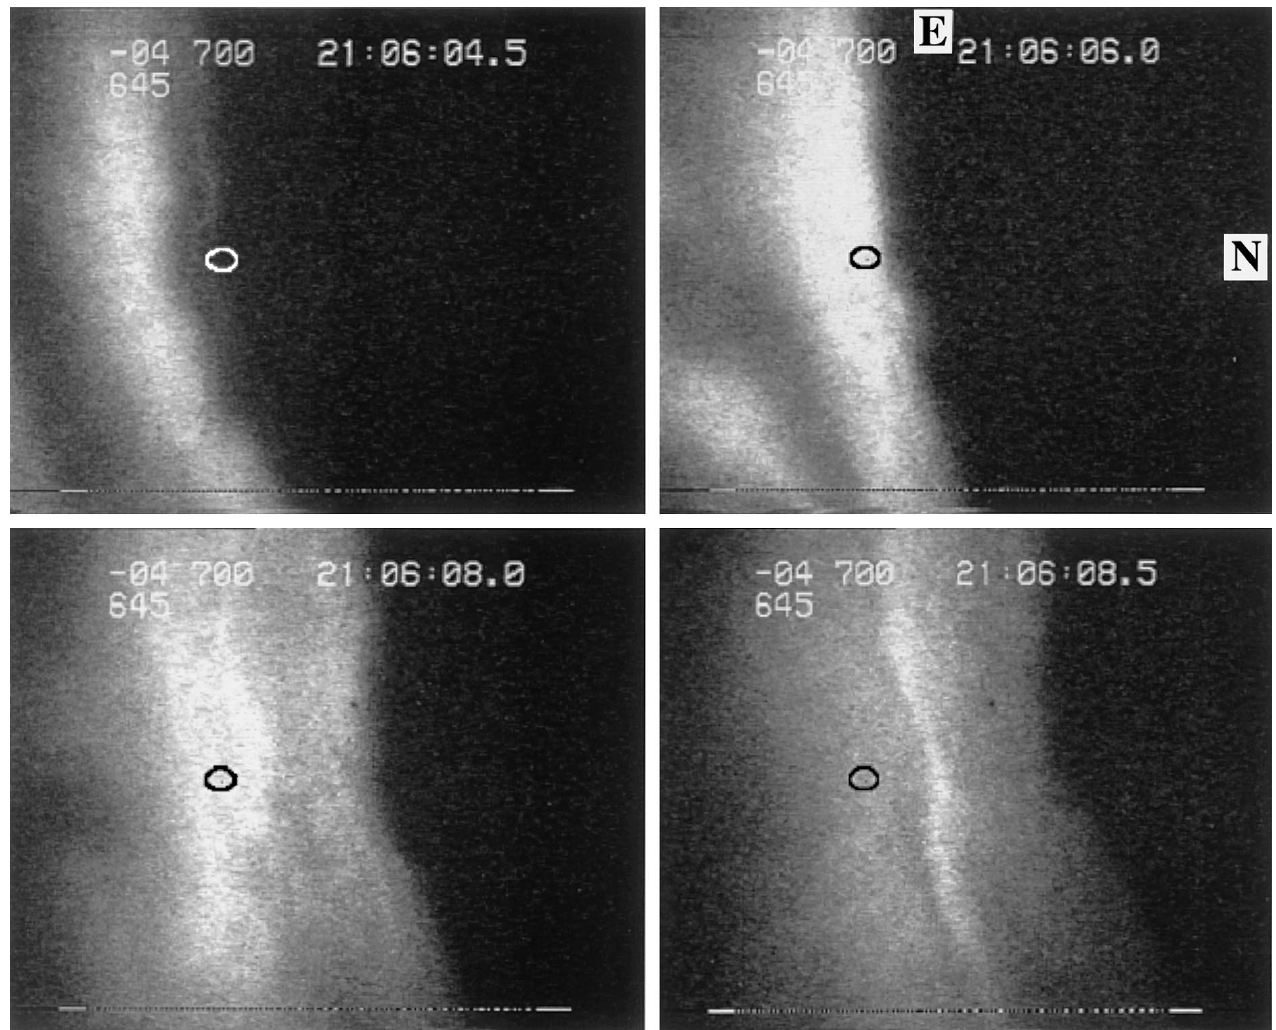
Fig. 3. Images from the narrow-angle TV camera at 21:06:04.5, 06.0, 08.0 and 08.5 UT. The position of the radar and photometer fields of view is marked. The field of view of the camera is 38 km (cid:180) 28 km at 100 km, with north to the right and east at